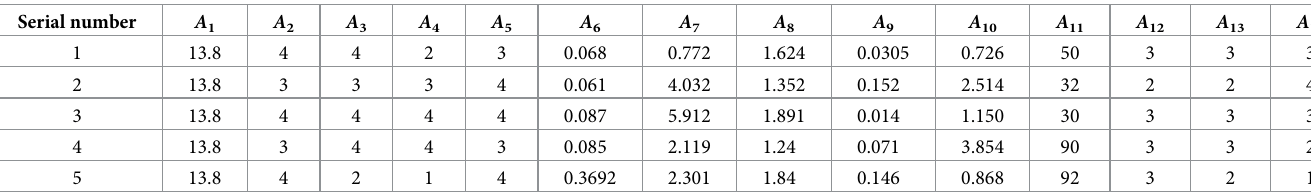
Table 2. Original data of SCF-oriented RAIS.